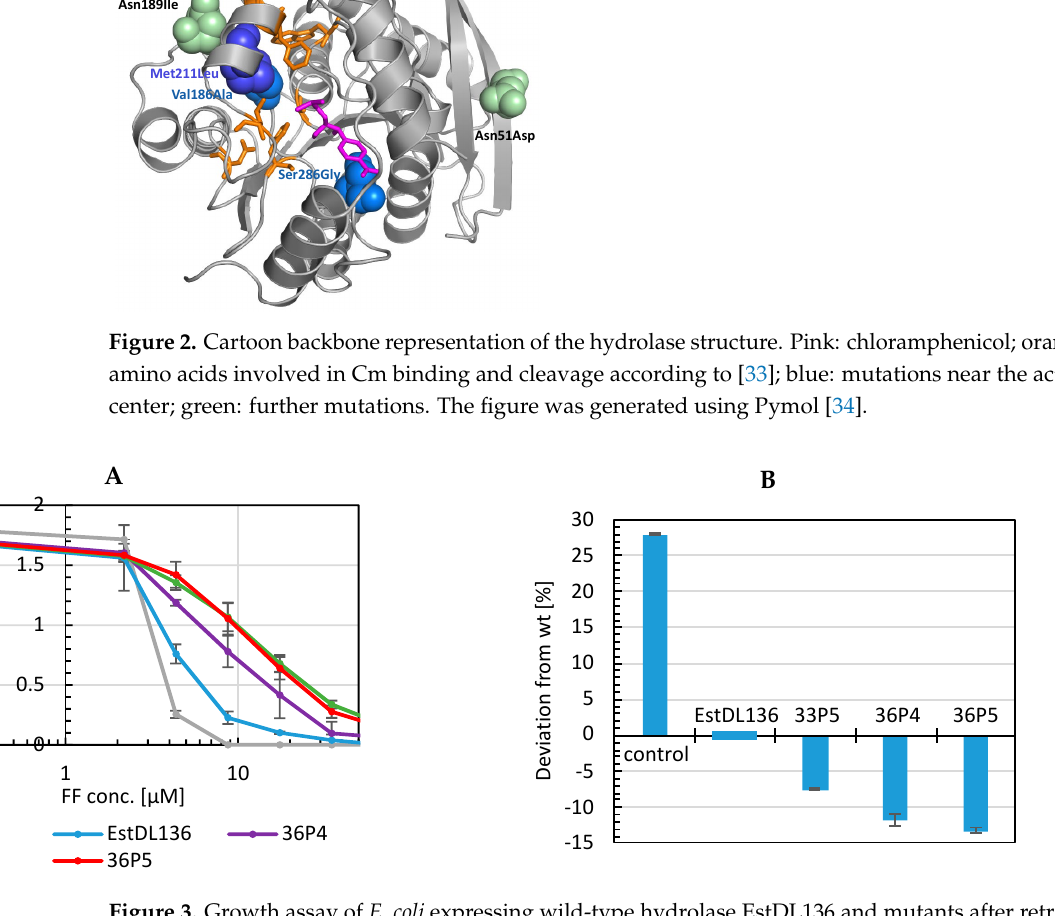
Figure 3. Growth assay of E. coli expressing wild-type hydrolase EstDL136 and mutants after re- transformation ( A ) Comparison of selected mutants in liquid media containing different FF concen- tration ( n = 5 (EstDL136); n = 4 (33P5, 36P4); n = 6 (36P5); n = 2 (control = BL21 without plasmid)); ( B ) Inhibition zone assay. The size of the inhibition zone was measured from scanned plates and calcu- lated as a percentage deviation from cells expressing the wild-type hydrolase EstDL136.